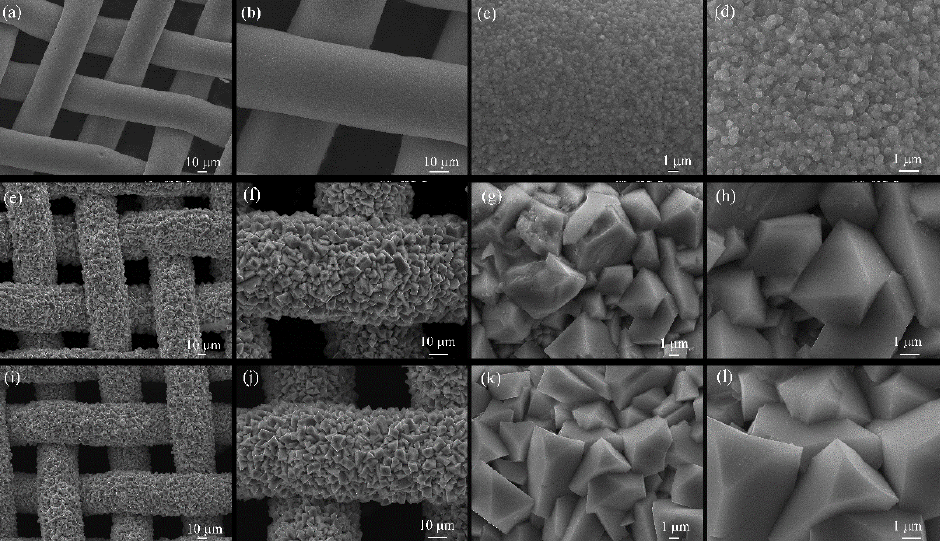
Figure 6. SEM micrographs of ZnMn 2 O 4 prepared for ( a – d ) 6 h, ( e – h ) 12 h, and ( i – l ) 18 h at different magnifications of ( a , e , i ) ×450, ( b , f , j ) ×1000, ( c , g ,k) ×5000, and ( d , h , l ) ×10,000. magnifications of ( a , e , i ) × 450, ( b , f , j ) × 1000, ( c , g , k ) × 5000, and ( d , h , l ) × 10,000.